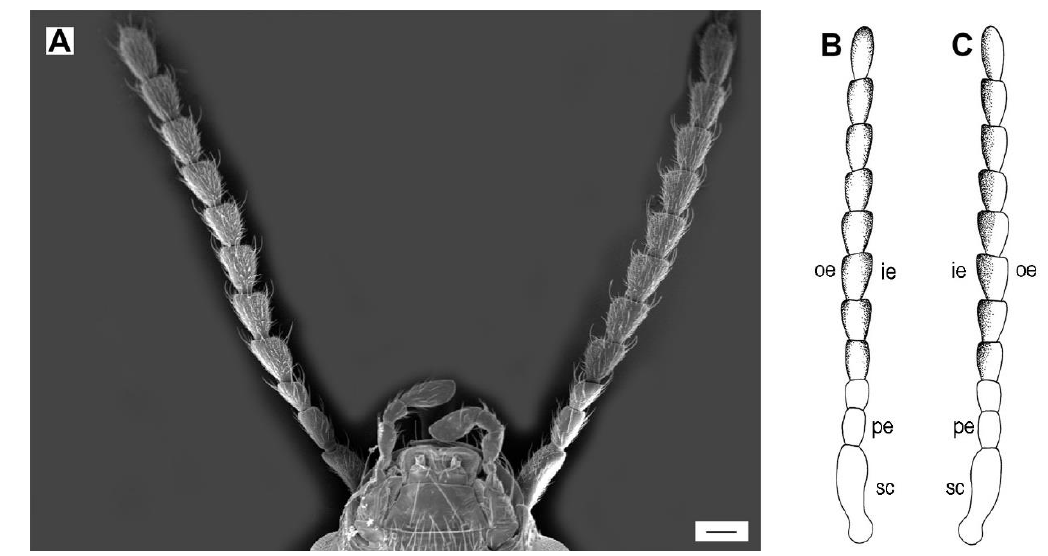
Figure 2. General morphology of Agriotes antennae. ( A ) A. acuminatus , male, antennae and frontal part of head, ventral view; ( B ) Sensillar fields on dorsal surface of antennae, schematic; ( C ) Sensillar fields on ventral surface of antennae, schematic. oe, outer edge; ie, inner edge; sc, scape; pe, pedicel. Scale bar = ( A ): 100 μm; ( B , C ): not to scale.